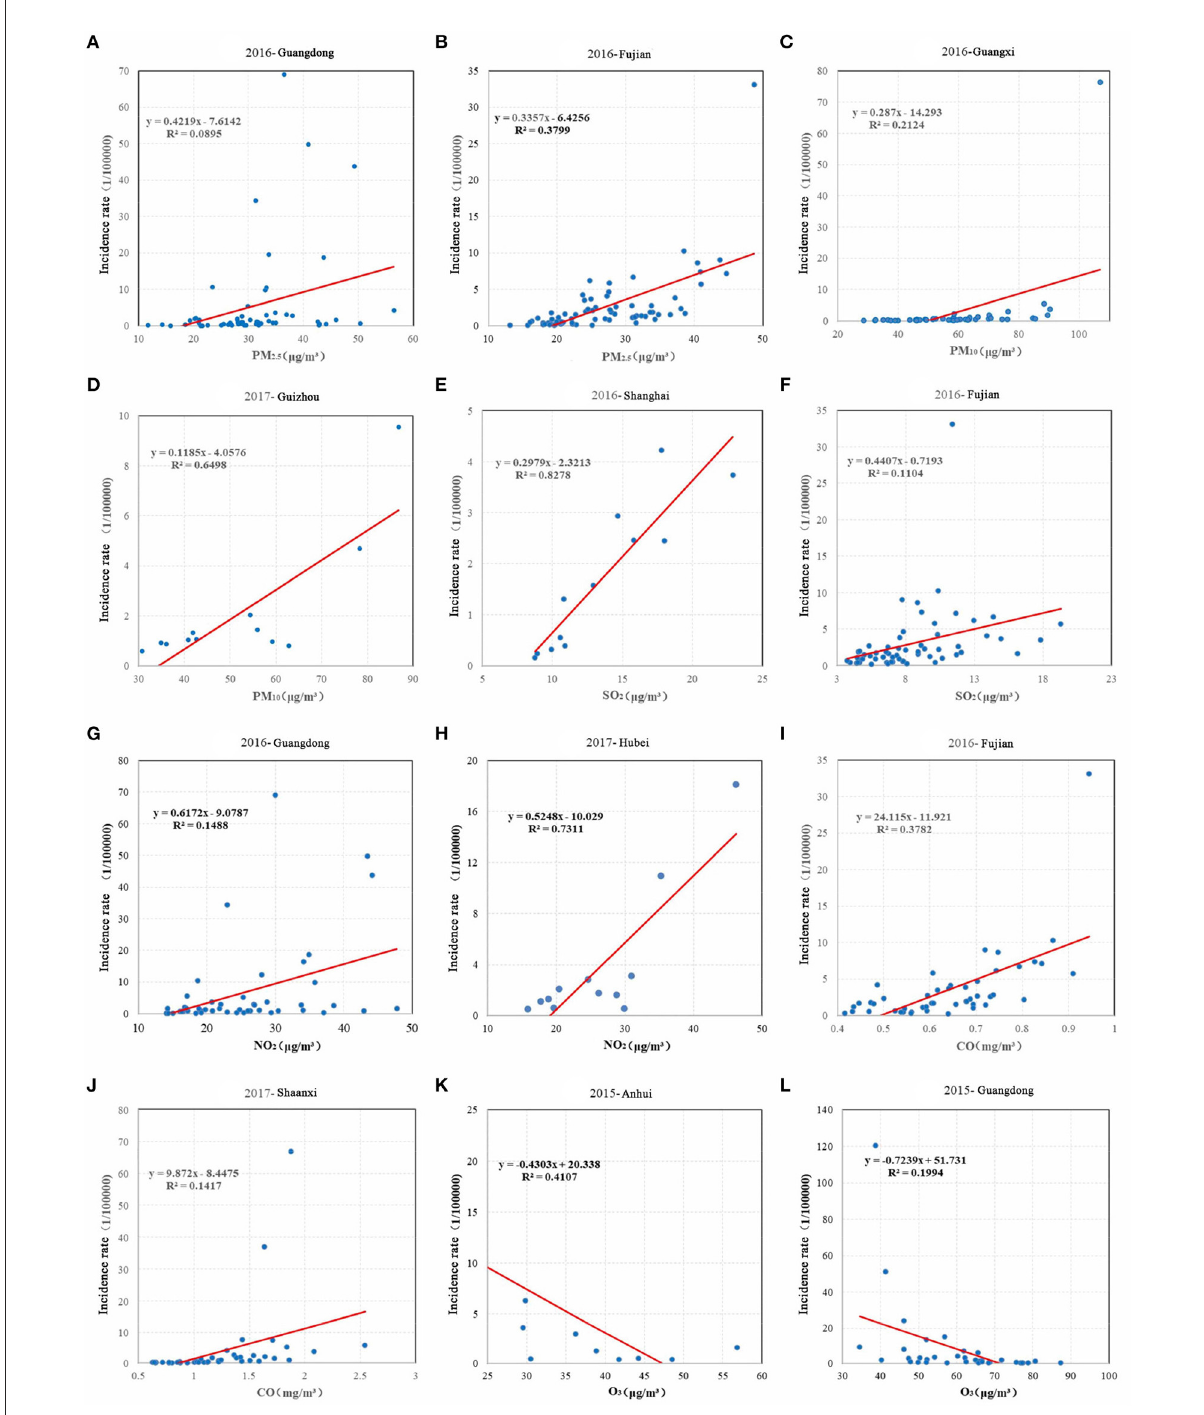
FIGURE6 Scatter fitting of the influenza incidence and air pollution in typical sensitive provinces during 2014-2017. (A) Regression fitting of PM 2.5 and incidence rates in Guangdong Province in 2016. (B) Regression fitting of PM 2.5 and incidence rates in Fujian Province in 2016. (C) Regression fitting of PM 10 and incidence rates in Guangxi Province in 2016. (D) Regression fitting of PM 10 and incidence rates in Guizhou Province in 2017. (E) Regression fitting of SO 2 and incidence rates in Shanghai Province in 2016. (F) Regression fitting of SO 2 and incidence rates in Fujian Province in 2016. (G) Regression fitting of NO 2 and incidence rates in Guangdong Province in 2016. (H) Regression fitting of NO 2 and incidence rates in Hebei Province in 2017. (I) Regression fitting of CO and incidence rates in Fujian Province in 2016. (J) Regression fitting of CO and incidence rates in Shaanxi Province in 2017. (K) Regression fitting of O3 and incidence rates in Anhui Province in 2015. (L) Regression fitting of